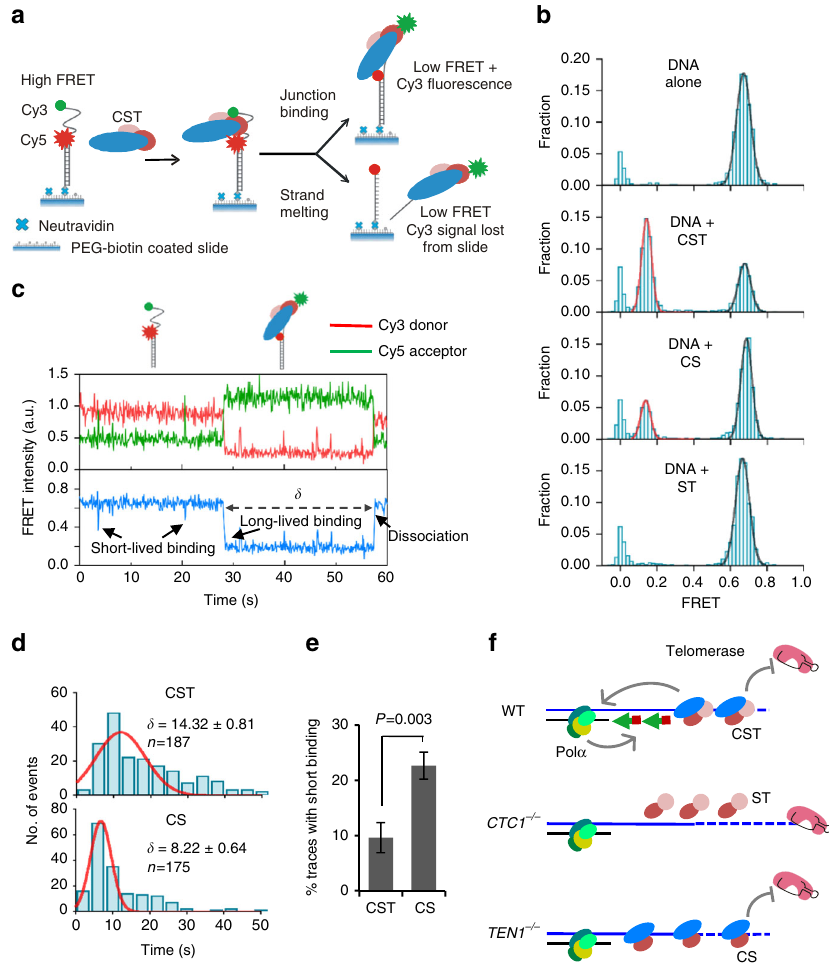
Fig. 6 Removal of TEN1 destabilizes CTC1-STN1 binding. Single molecule FRET analysis of CST, CS or ST binding to DNA junction substrate with 18 nt overhang. a Cartoon showing design of the non-telomeric junction substrate and anticipated FRET signals in the presence or absence of CST. In the absence of CST the fl exibility of the 18 nt ssDNA will bring the Cy3 donor and Cy5 acceptor into close proximity and give a high FRET signal. If CST binds without melting the anchoring DNA duplex, the high FRET signal will be lost but emission from the Cy3 donor (green) will be retained. If CST melts the DNA duplex, both the high FRET and the Cy3 donor signal will be lost. b FRET histograms generated from FRET measurements of >4000 single molecules. The zero FRET peak re fl ects DNA molecules with an inactive or missing Cy3 label. c smFRET real-time trace showing change in individual Cy3 and Cy5 signals (top) and FRET (bottom) with time. Dwell time ( δ ), long-lived binding, short-lived binding and dissociation events are indicated. d Distribution of dwell times for CST or CS binding before protein dissociation. Histogram shows number of binding and dissociation events within the indicated 4 s time intervals. Red line shows the calculated Gaussian distribution. e Percent of traces showing a short-lived trough in FRET signal after CS or CST addition. Error bars indicate SEM. f A model depicting effects of CTC1 or TEN1 loss on ability of remaining CST subunits to restrain telomerase action and mediate C- strand fi